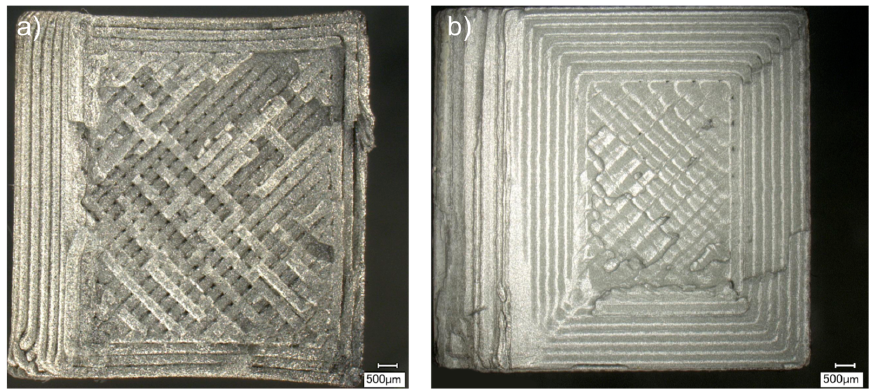
Figure 16. Fractured faces of the Charpy test metal FFF specimens presented as: ( a ) fractured surface (SEM image) of Ultrafuse BASF 316L specimen; ( b ) fractured surface (SEM image) of Markforged 17-4 PH specimen.